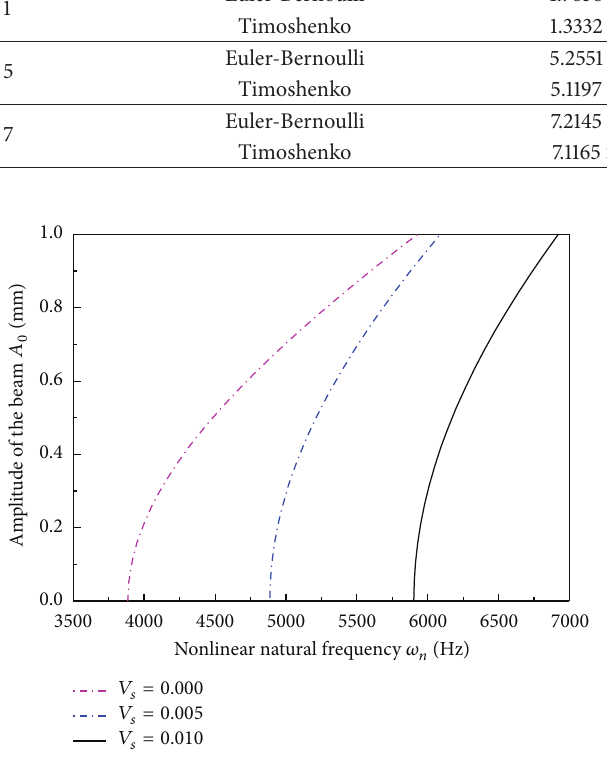
Figure 6: Variation of the nonlinear natural frequency with the free vibration amplitude 𝐵 0 for different 𝑉 𝑠 ( T = 50 ∘ C, 𝜀 0 = 0.005 , and 𝐿/ℎ = 10 ).